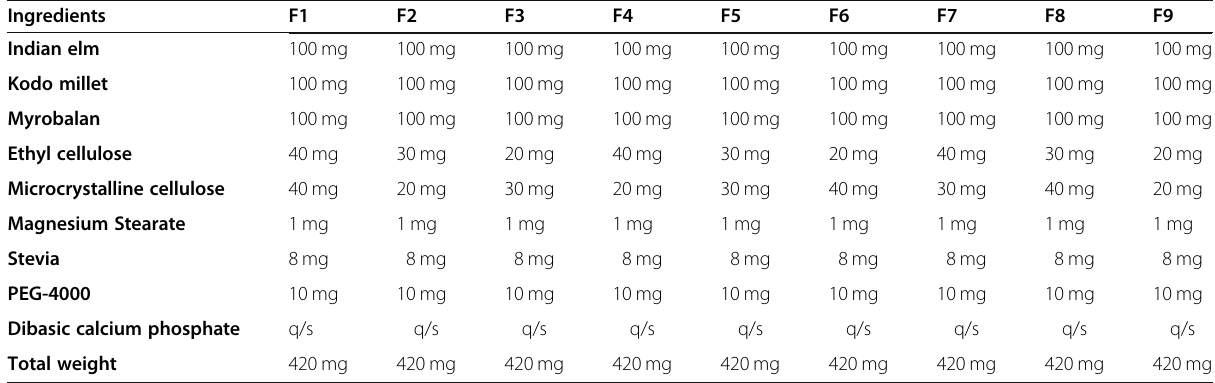
Table 2 Formula table